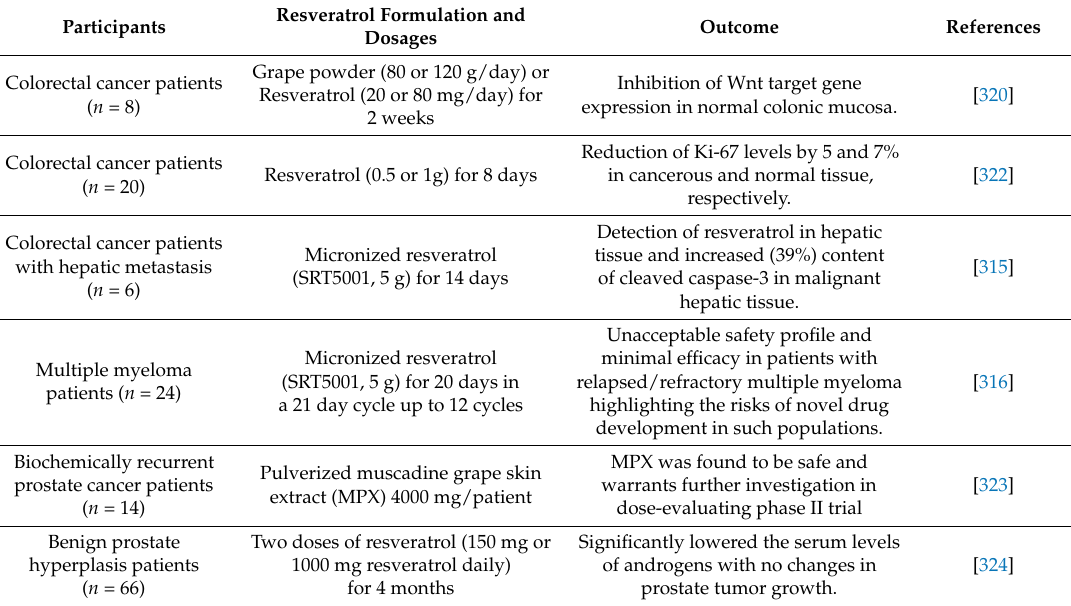
Table 2. Selected clinical trials evaluating the effect of resveratrol in cancer patients. Resveratrol Formulation and Participants Dosages